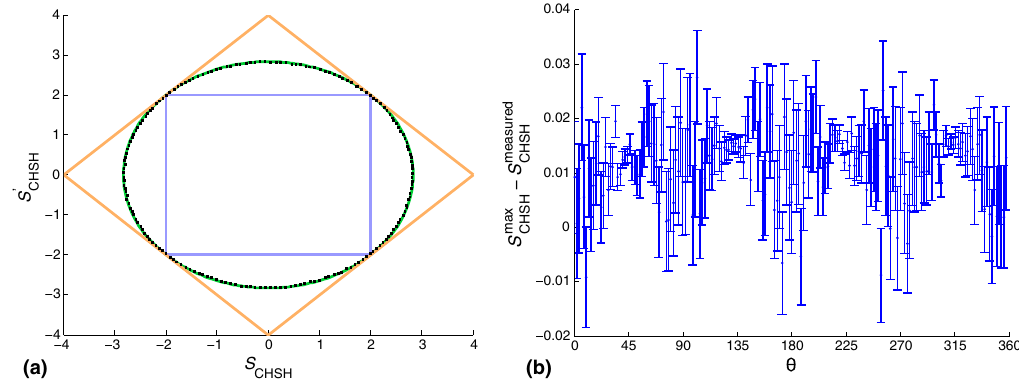
FIG. 3. Testing the boundary of quantum correlations in the simplest Bell test scenario. (a) Plot of the experimental measurements of the curve Eq. (6). Here, local correlations ( L ) form the inner blue square, no-signaling correlations form the outer orange square (the vertices represent the PR box and its symmetries), and quantum correlations form the green circle; the black dots are the 180 measured data points, all of whose error bars lie within the thickness of the dot. (b) A comparison of the analyzed data with the quantum ffiffiffi p 2 mechanical maximum ( 2 ). Here, θ is defined in Eq. (6) and corresponds to rotating around the circle in Fig. 3(a). The vertical axis is ffiffiffi p 2 the distance from 2 of the radius of curve formed by S 0 and S (i.e., the radius of the data point at a given θ ). Plotted values ffiffiffi CHSH CHSH p 2 greater than zero correspond to measured values less than 2 . Here, the uncertainty is smaller for measurements around the vertices of the local correlations (at 45°, 135°, 225°, and 315°) due to large correlations between S 0 and S . We observe 8 data points beyond CHSH CHSH the quantum limit, which we expect to happen with a probability of